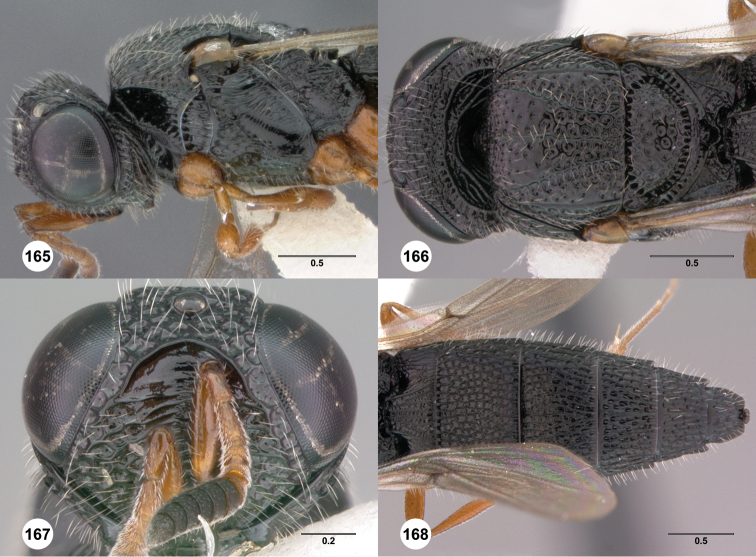
Oxyscelio liminis sp. n., holotype female (OSUC 376712) 165 Head and mesosoma, lateral view 166 Head and mesosoma, dorsal view 167 Head, anterior view 168 Metasoma, dorsal view. Morphbank59